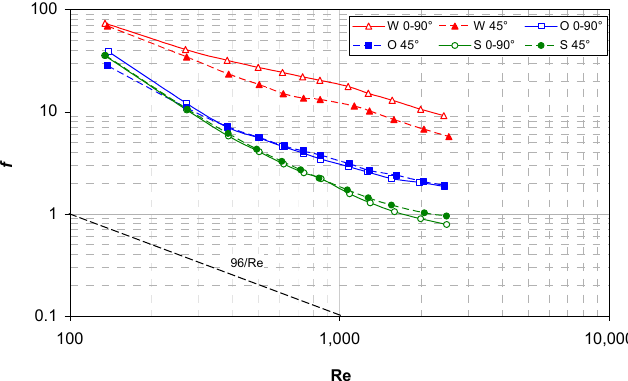
Figure 5. Darcy friction coefficient f as a function of the Reynolds number for all of the configurations investigated. The theoretical friction coefficient for laminar flow in a plane channel (96/Re) is also reported for comparison purposes.